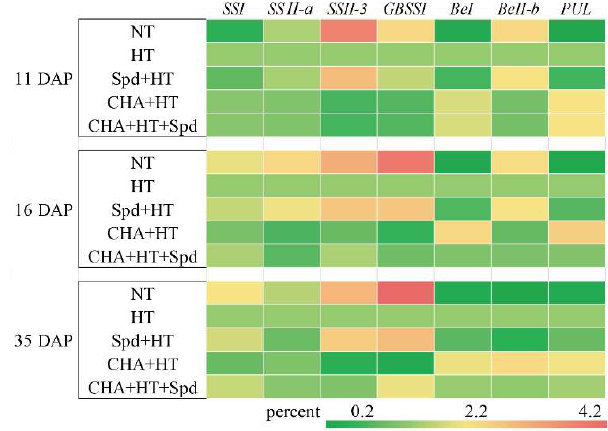
Figure 4. Effects of exogenous Spd and CHA on the starch synthesis-related gene expressions of rice seeds during development under high temperature (40 °C, 5 days). The expression level of HT was